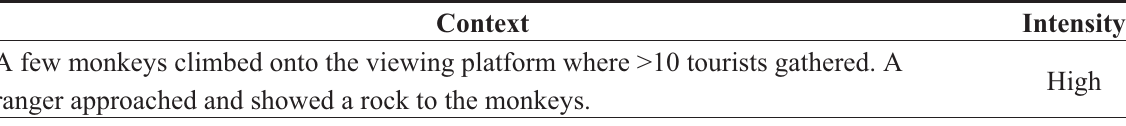
Table 3. Contexts of park ranger Team A interventions in tourist-monkey interactions. Team B was not observed to intervene in tourist-monkey